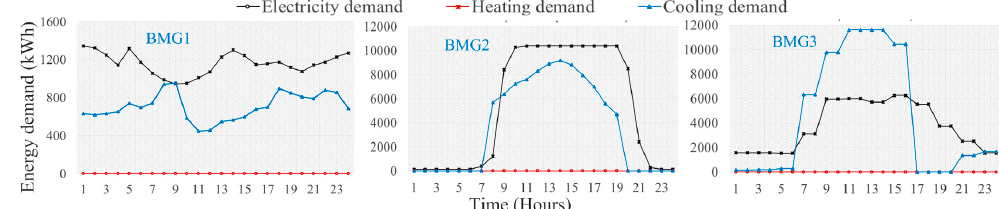
Figure 3. Electricity, heating, and cooling demand profiles of BMGs in summer season.